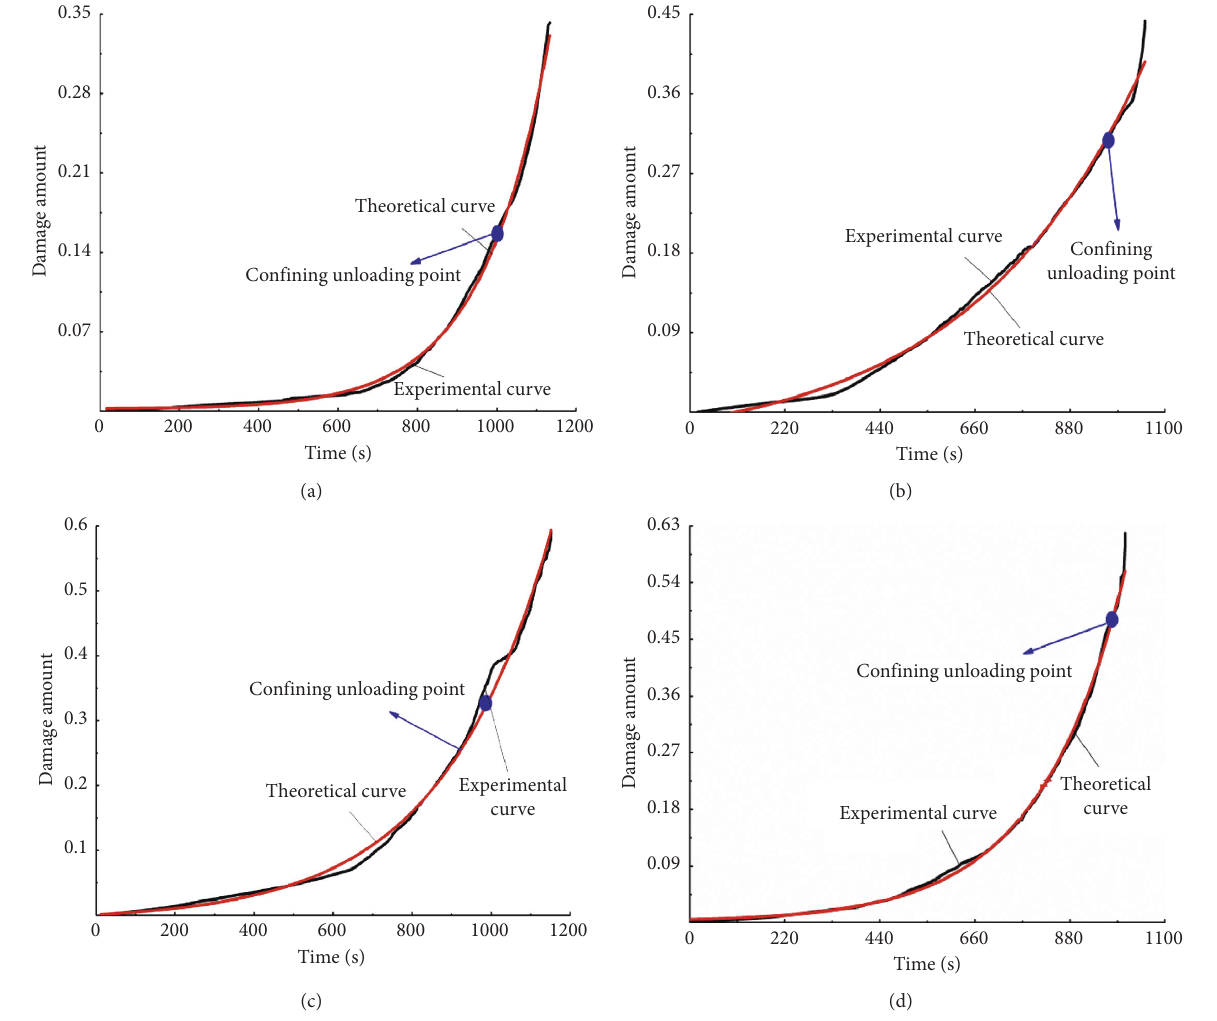
Figure 12: Comparison of theoretical and experimental curves of coal sample damage under different unloading rates. (a) 0.1 MPa/s unloading rate. (b) 0.2 MPa/s unloading rate. (c) 0.4MPa/s unloading rate. (d) 0.6MPa/s unloading